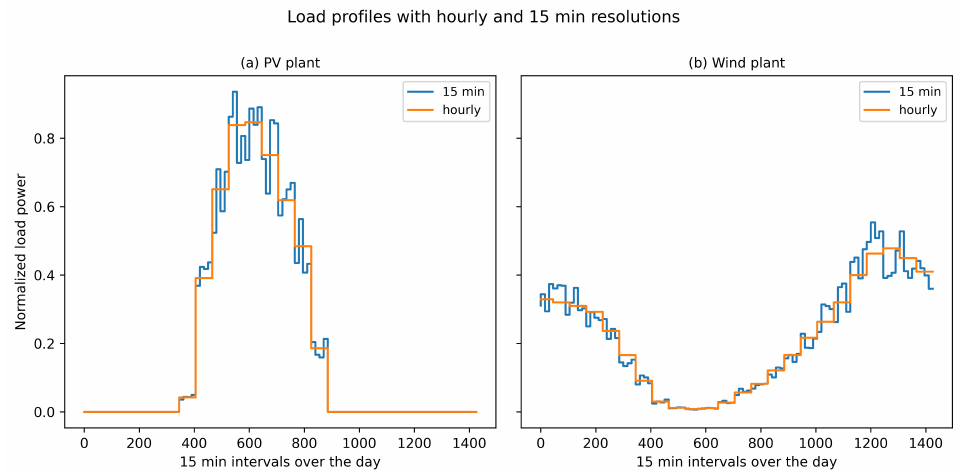
Figure 15. DG output profiles with 15 min resolution generated (according to (3)) from hourly resolution (for example, for the first day in a year): ( a ) PV DG; ( b ) Wind